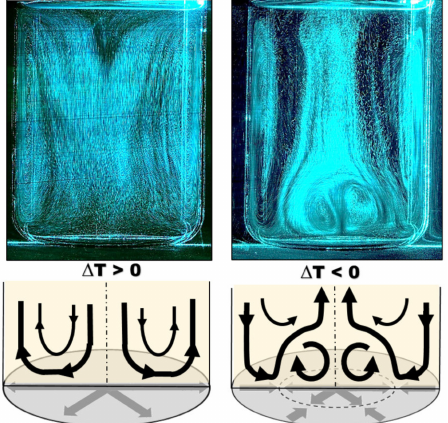
Figure 1. Flow behavior within the wine bulk, and flow directions near the bottom surface of the container, under a low positive thermal gradient of + 3 ◦ C (left), and a low negative thermal gradient of − 3 ◦ C (right), respectively 15 min after the start of the heating / cooling process of the room.